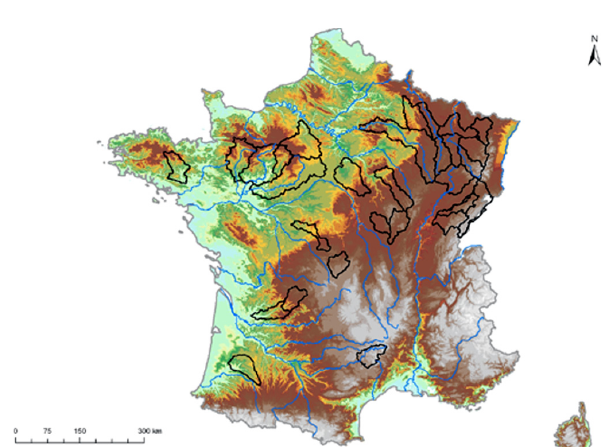
Fig. 1. Location of the 29 studied catchments in